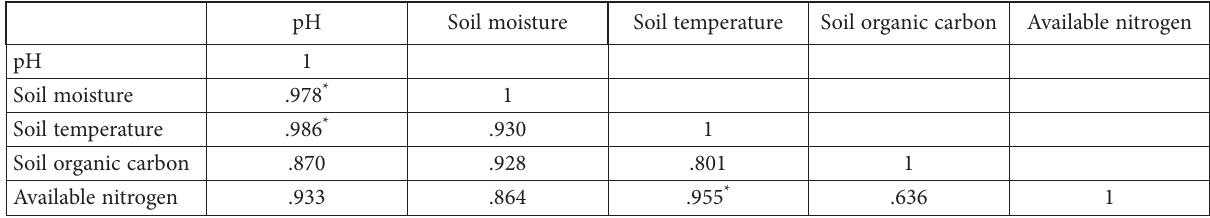
Table 3. Correlation matrix among the soil parameters at FRS